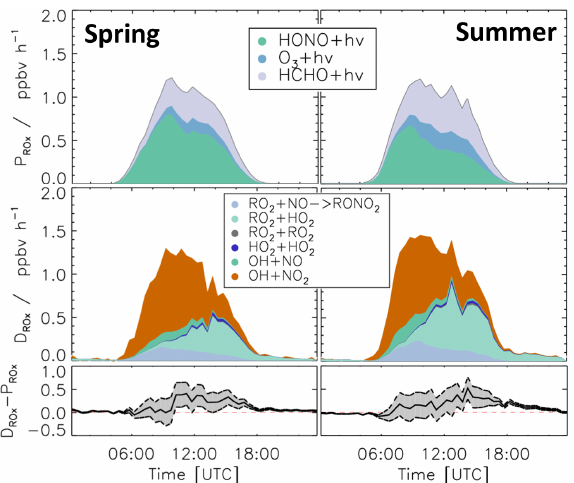
Figure 9. Median values of production and destruction rates of RO X radicals during the spring and summer periods of the JULIAC campaign. In addition, the differences between the destruction and production rates are shown. Grey areas indicate the 1 σ uncertainty derived from experimental errors of the measured quantities (Ta- ble 2) and of the reaction rate constants (Table 1). The reactions that have insignificant contributions to the production or destruc- tion rates are not